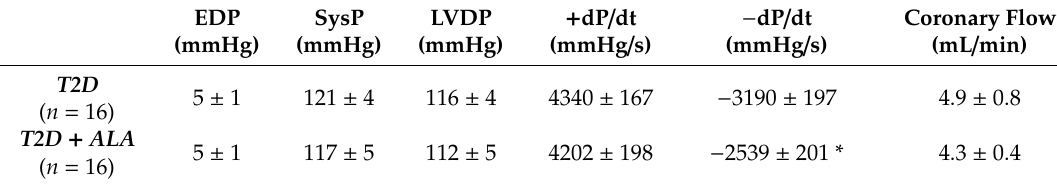
Table A3. Normoxic Function in Hearts from T2D Mice ± ALA